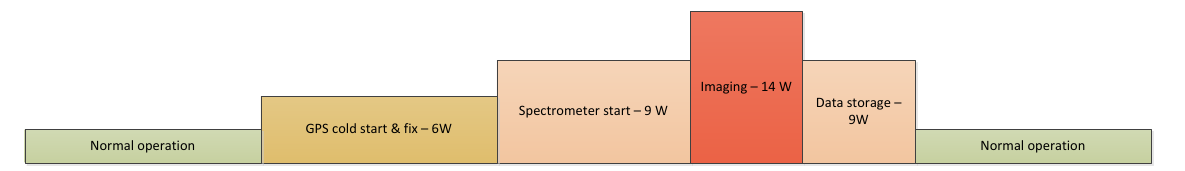
Fig. 6. The imaging sequence (not to timescale) with the spectral imager and associated total satellite power usage at an orbit height of 700km, the total time taking a few minutes for this whole sequence (GPS cold-start is by far the longest, the rest requiring around a second per operation block). As the spectral imager technology develops further, the power and time requirements presented here will most likely lessen. The power values here represent the total satellite power usage during a particular operation block within the imaging sequence.